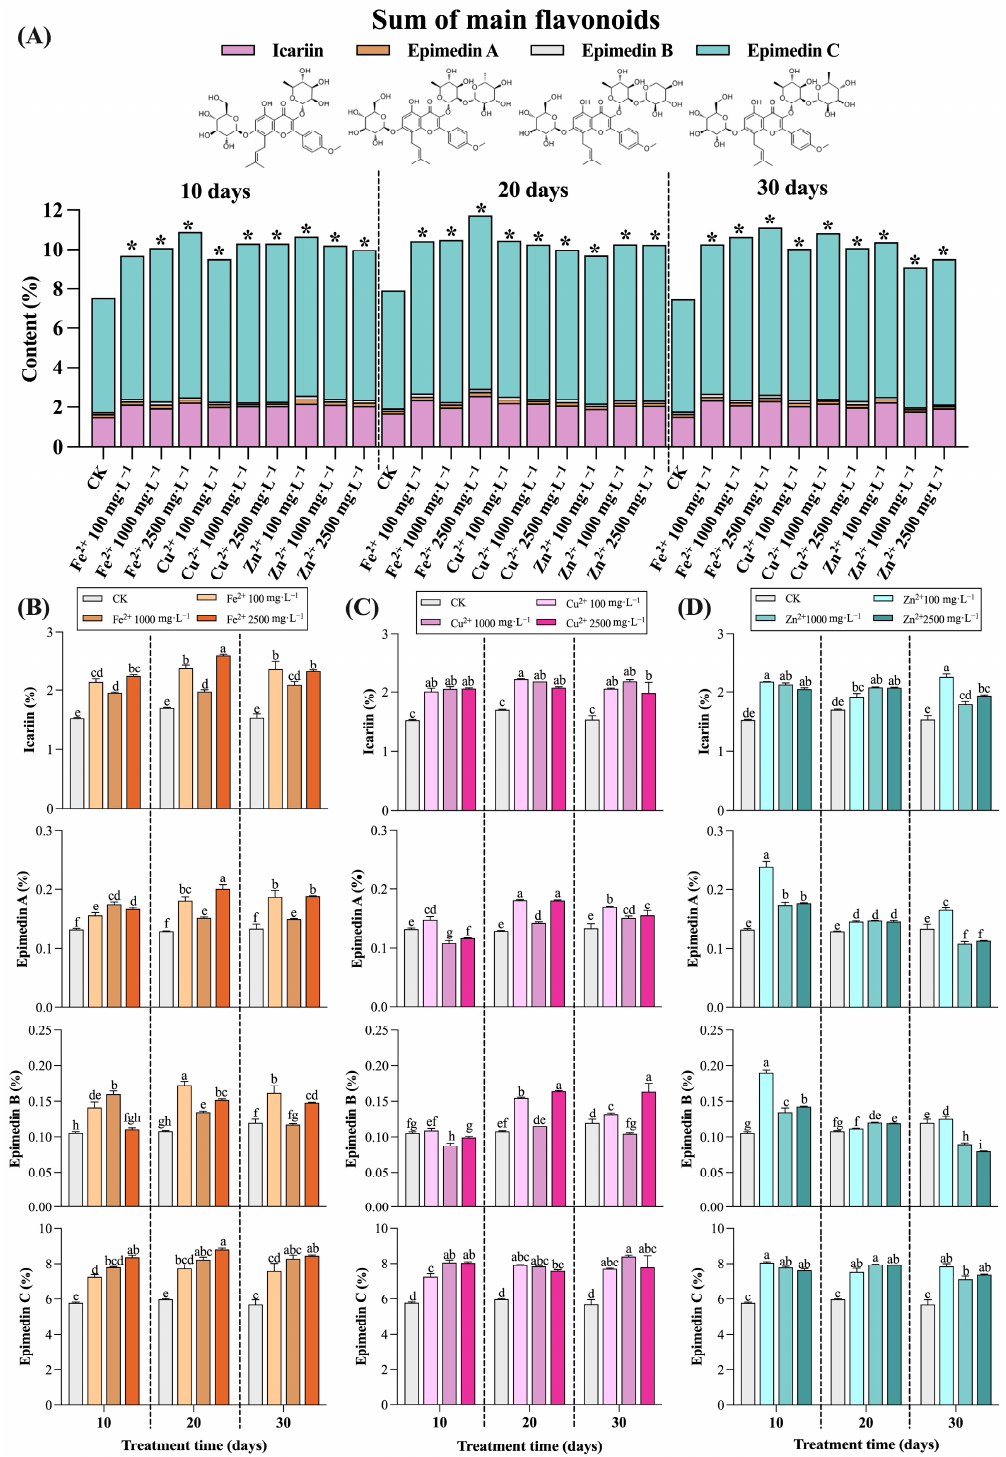
Figure 2. The changes of flavonoids in E. sagittatum leaves after spraying with mineral elements (10 days, 20 days, and 30 days). The data are expressed as the means ± SDs (standard deviations, n = 3). ( A ) The sum of main flavonoids in E. sagittatum leaves after spraying with Fe 2+ , Cu 2+ , and Zn 2+ (10 days, 20 days, and 30 days). * indicates a significant difference between the treatment group and the control group. ( B – D ) The changes of icariin, epimedin A, epimedin B, and epimedin C in E. sagittatum leaves after spraying with Fe 2+ ( B ), Cu 2+ ( C ), and Zn 2+ ( D ) (10 days, 20 days, and 30 days). The different lowercase letters indicate significant differences between treatments ( p < 0.05) determined by Duncan’s single-factor variance